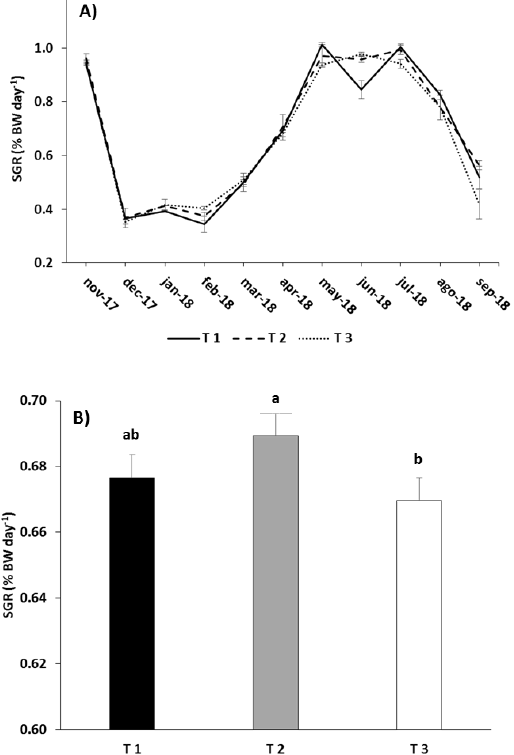
Figure 2. Monthly ( A ) and overall ( B ) values of specific growth rate (SGR) in the different experimental feeding treatments (mean ± standard error). Different letters above the columns indicate significant differences (Tukey HSD, P < 0.05) between feeding treatments. Table 6. Results of the repeated measures analysis of variance (RM-ANOVA) comparing growth performance, waste production and economic profitability variables among experimental feeding treatments ( P -values in bold indicate significant differences).